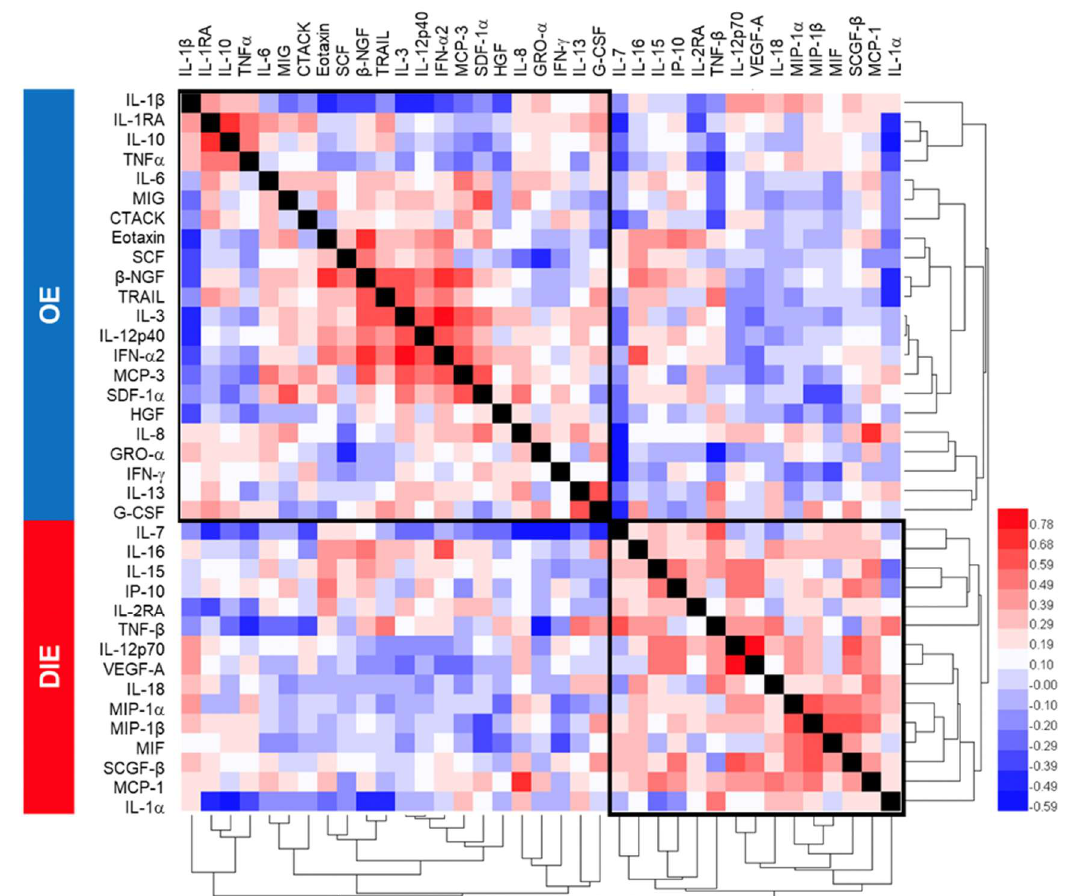
Figure 3. Correlation matrix of peritoneal fluid cytokines. Hierarchical clustering was performed on Spearman r -values between the subphenotypes ovarian endometriosis, and deep infiltrating endometriosis revealed consistency in PLSR-derived cytokine signatures that segregated OE from DIE.